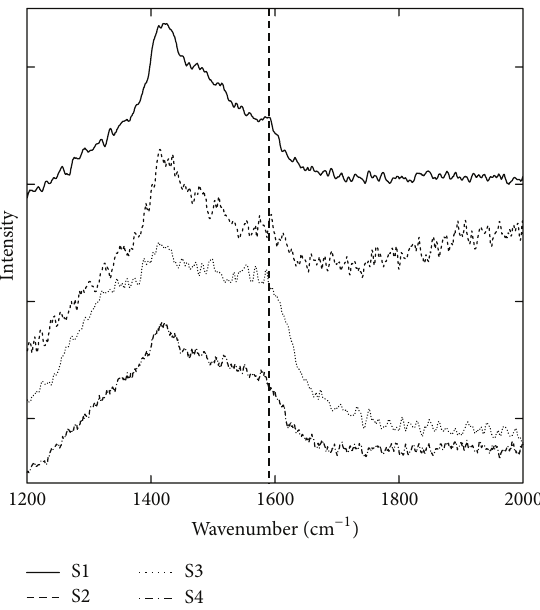
Figure 6: Raman spectra of Zuota samples. The position of 1590cm −1 was indicated by the dash line.